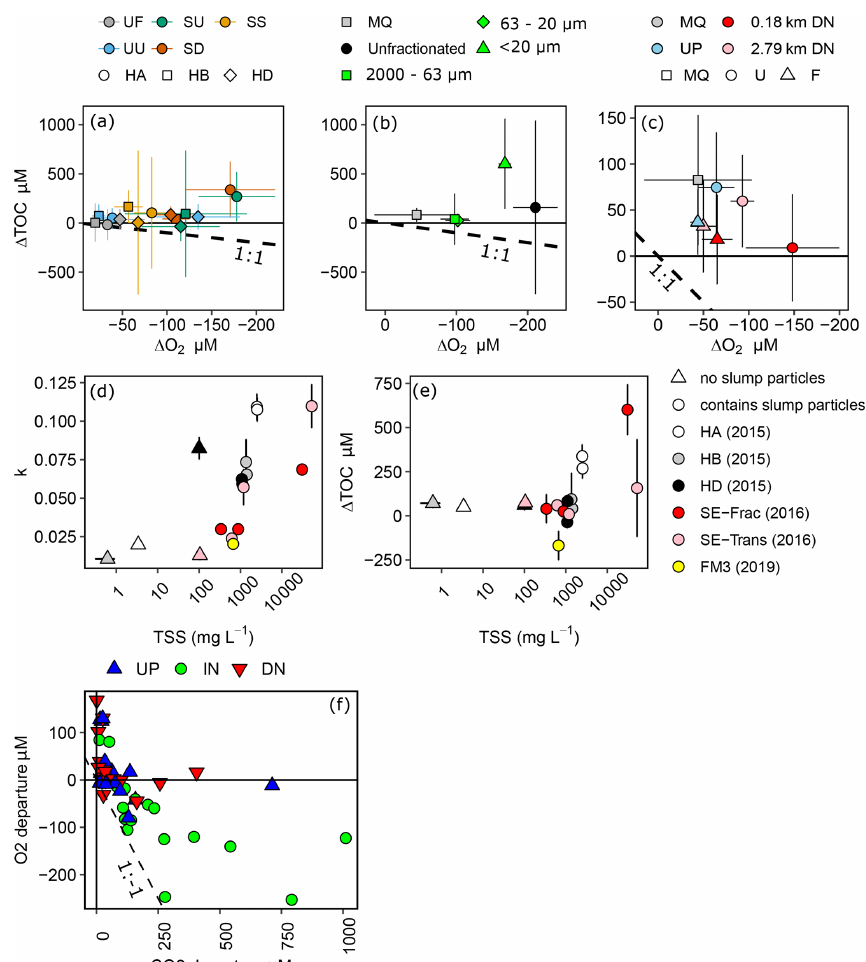
Figure 4. Concentration changes in TOC vs. changes in dissolved O 2 for (a) 2015 experiments, (b) 2016 site SE fractionation experiment, and (c) 2016 site SE transect experiment. Dashed lines in (a) – (c) represent predicted loss of OC for respiratory quotient = 1, and error bars show 95% confidence intervals. (d–e) Exponential rate of O 2 consumption (k) or changes in TOC vs. initial TSS for treatments across experiments, excluding filtered, settled, and sterilized treatments from (a) – (c) . SE-Frac indicates the fractionated treatments from panel (b) . (f) Departures of O 2 and CO 2 from atmospheric equilibrium in samples collected upstream (UP), downstream (DN), and within (IN) a series of slump sites on the Peel Plateau. Error bars in (d) and (e) show standard error of the mean. Codes in (a) are filtered (UF) and unfiltered (UU) upstream, slump material in upstream (SU) and downstream (SD) filtrate, and SU settled out (SS). HA, HB, and HD are slump sites.